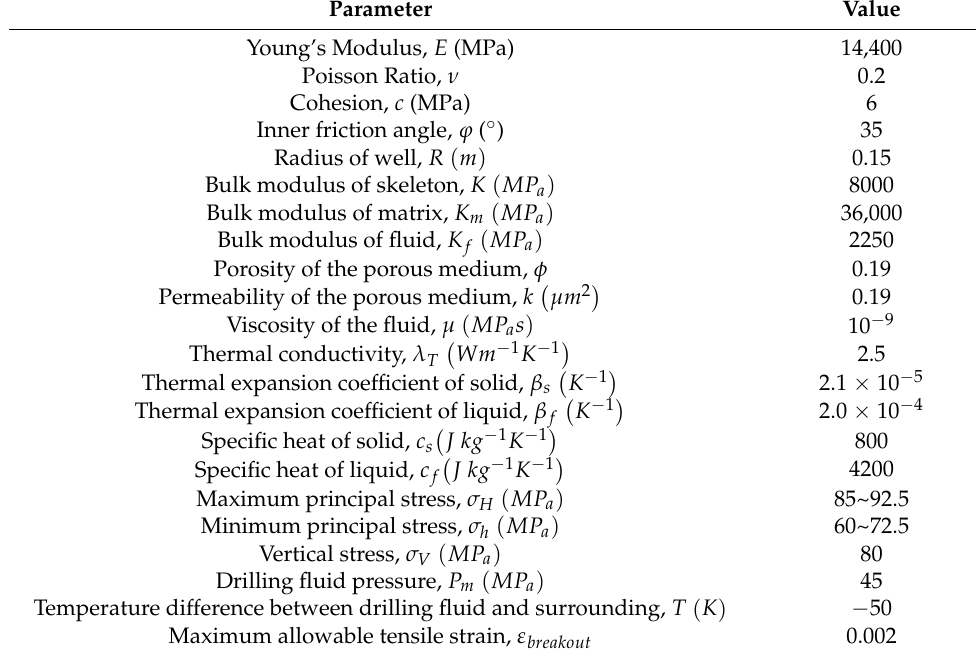
Table 1. Geometric and mechanical parameters.